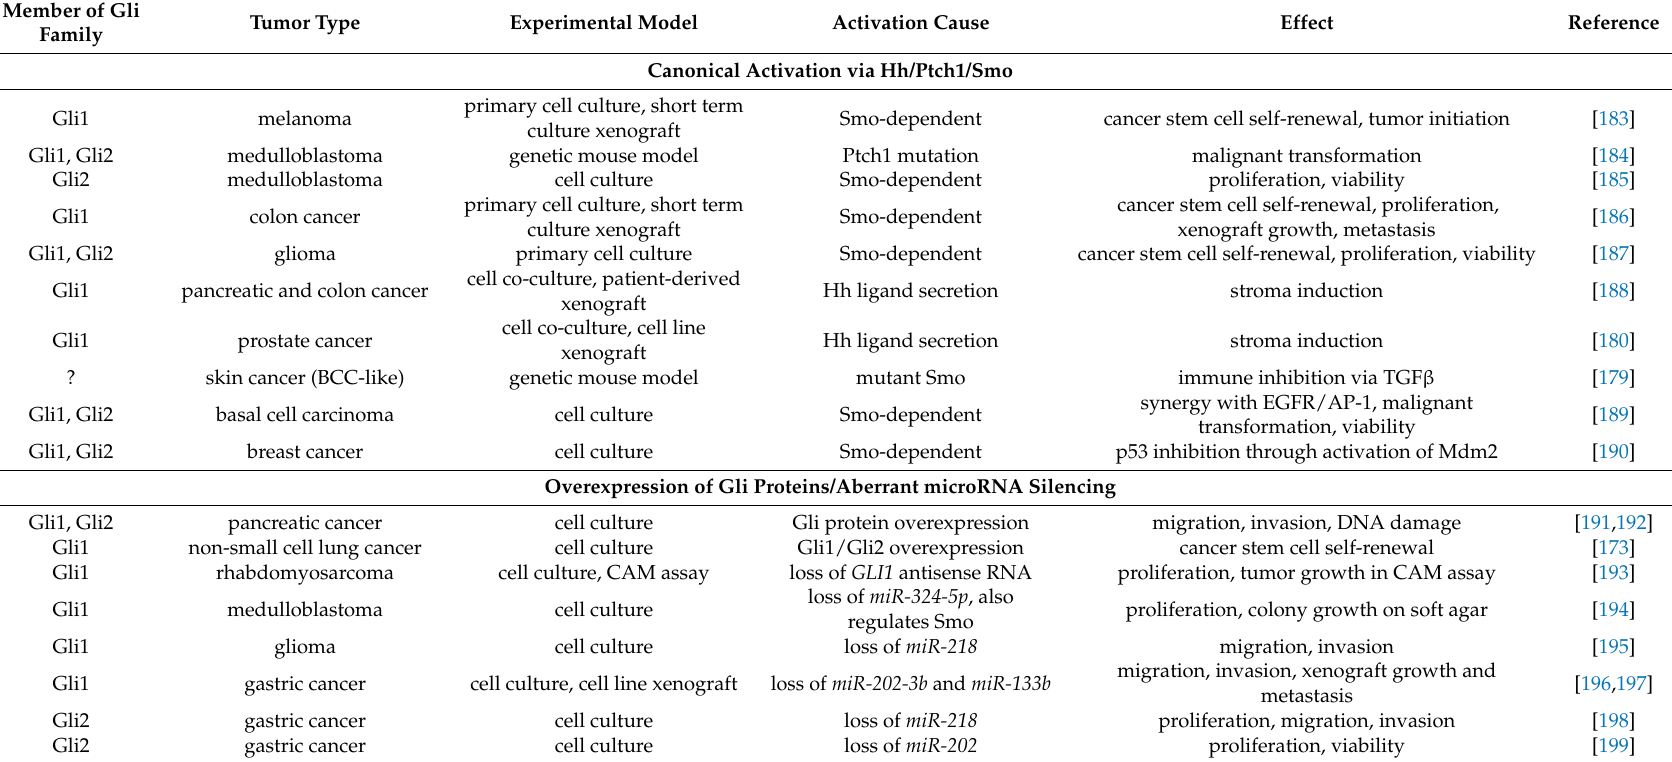
Table 2. Functional significance of Gli proteins in cancer based on loss-of-function